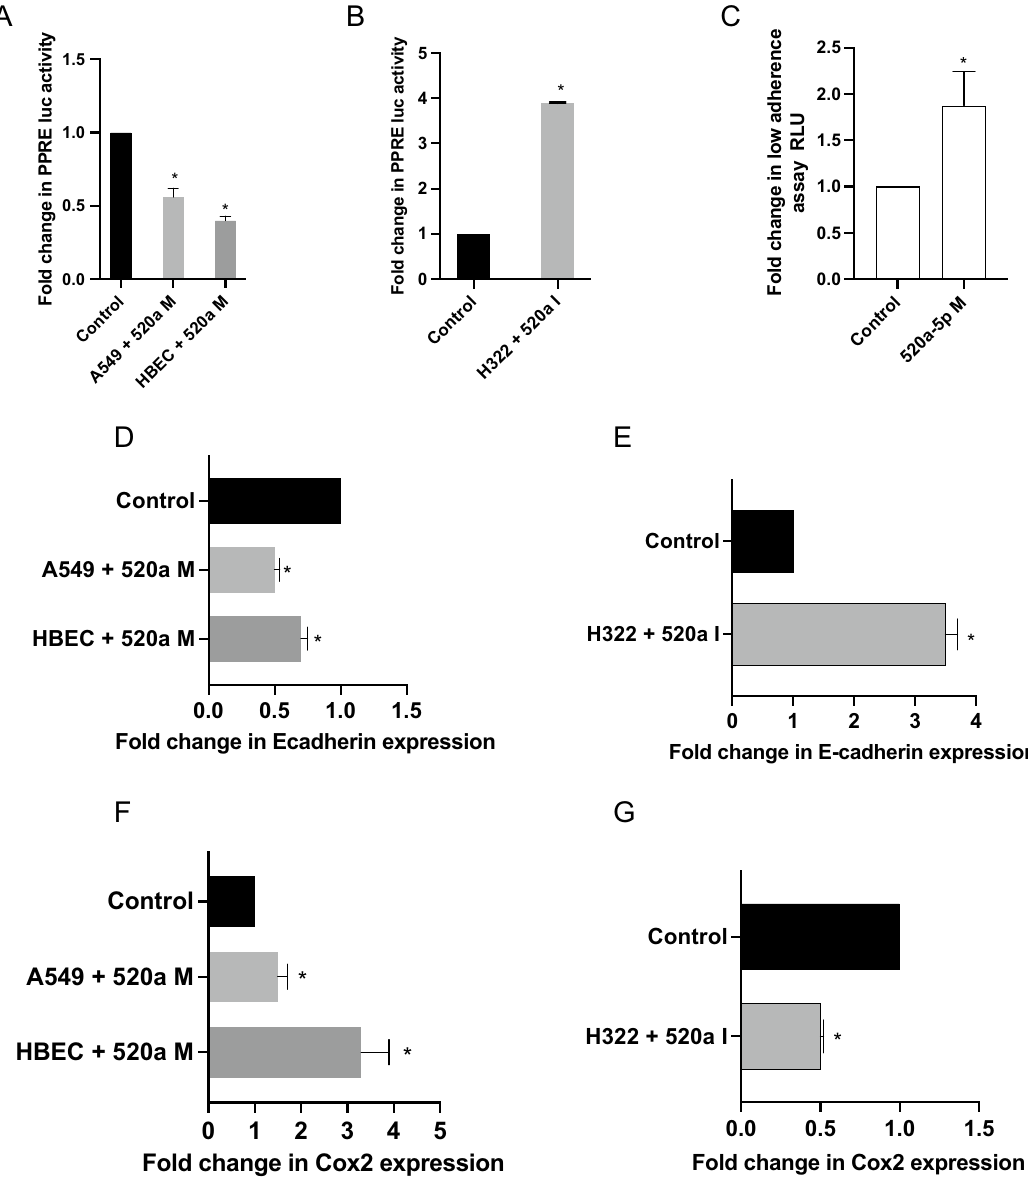
Figure 3. miR-520a-5p expression inhibits downstream function of FZD9. In A549 and HBEC ( A ) and H322 ( B ) cell lines, PPRE luciferase activity was measured after transfection of miR-520a-5p mimic or inhibitor and control. ( C ) A549 cells were transfected with miR-520a-5p mimic or control, cultured on a low-adherence plate for 48 h, and growth measured by fluorescent assay. After miR520a-5p mimic or inhibitor and control transfection, E-cadherin expression was measured in A549 and HBEC ( D ) and H322 ( E ) cell lines and Cox2 expression was measured in A549 and HBEC ( F ) and H322 ( G ) cell lines. Transfections were conducted in triplicate. Luciferase activity was measured in duplicate and shown relative to control for each cell line. mRNA expression was measured in triplicate by qPCR, normalized to GAPDH, and shown relative to control for each cell line. 520a M, miR-520a-5p mimic; 520a I, miR-520a-5p inhibitor. * p <